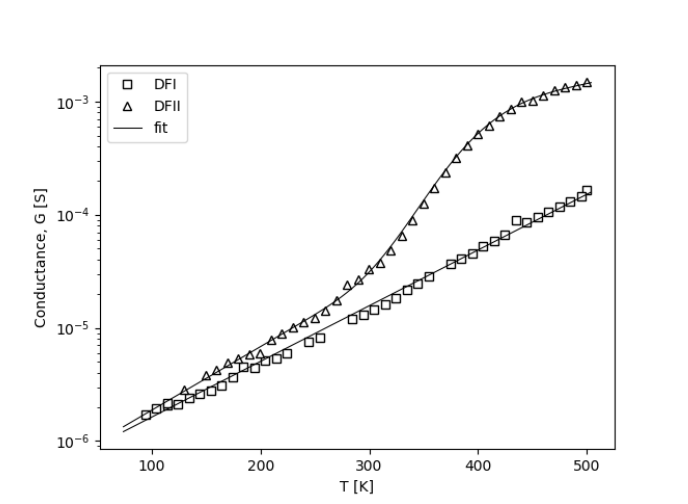
Figure 6. The temperature dependencies of the conductance G